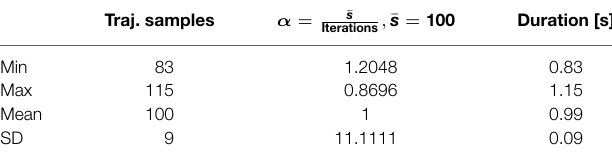
TABLE 2 | Information about trajectories’